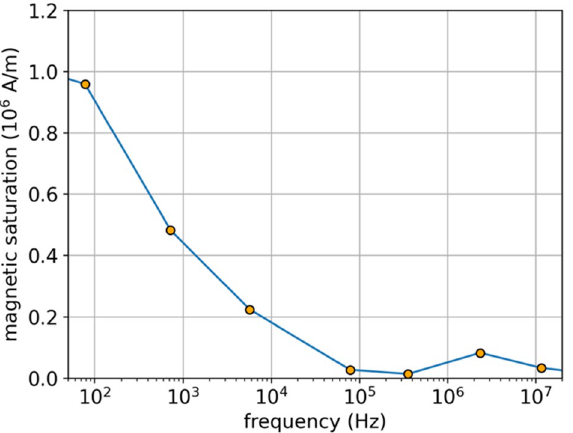
Figure 13. Magnetic saturation M s across frequencies that may enter JA model to make it frequency